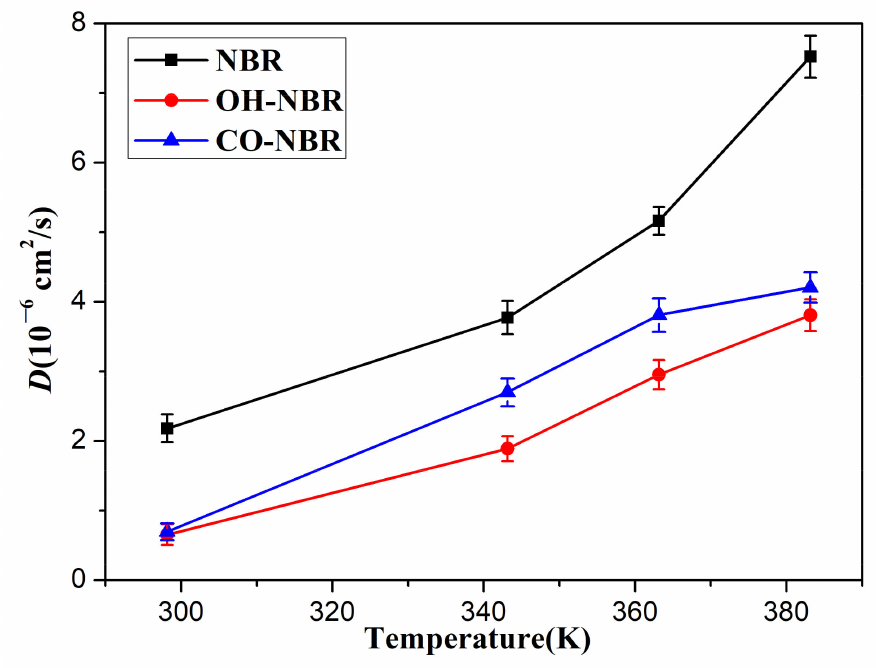
Figure 13. The diffusion coefficients of the cyclohexane molecules in the unaged and aged NBR models at different